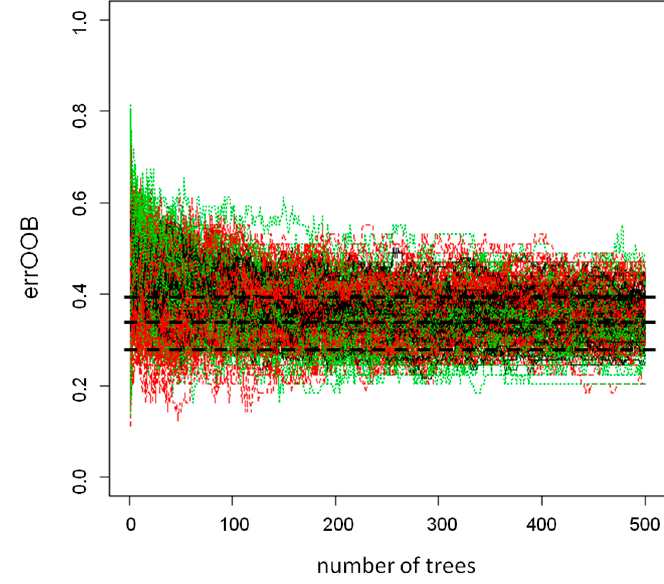
Figure 2. Random forest analysis of the COPSAC2010 dataset. Error-out-of bag (errOOB) versus the number of trees of the 500 random forests built on the COPSAC2010 dataset. Black, dashed lines indicate the 10th, 50th, and 90th percentiles of the errOOB. Red lines indicate the errOOB for the non-asthma group, the green lines that of the asthma group, and the black lines the total errOOB for each random forest. The total errOOB laid in the range of 0.28 to 0.39 after 300 trees. With more than 300 trees, the performance did not change.